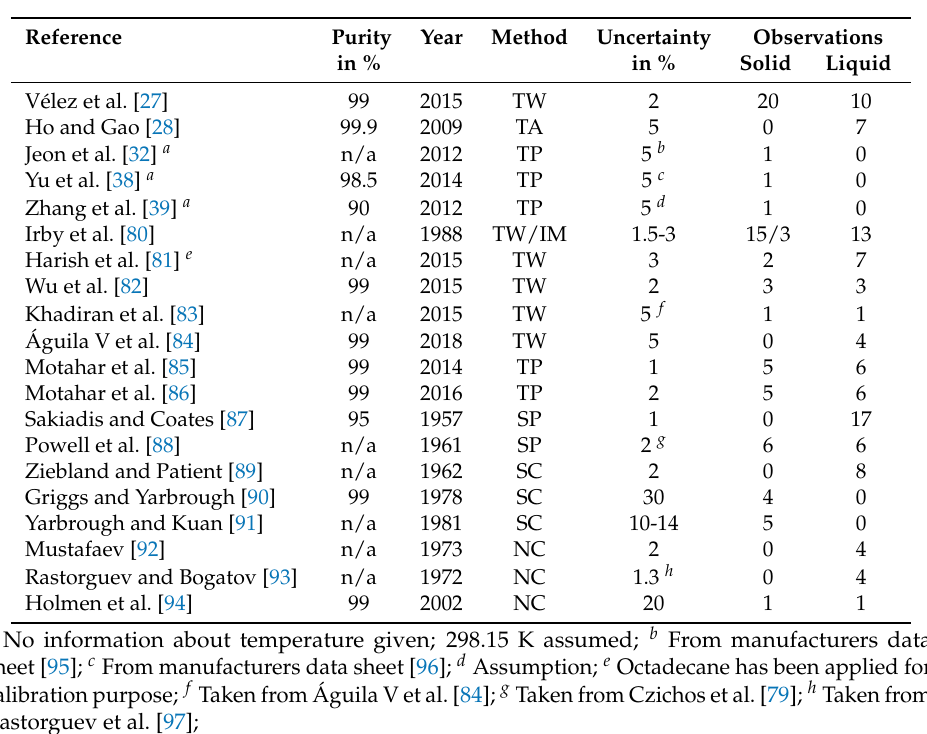
Table 4. Summary of thermal conductivity data from the literature.